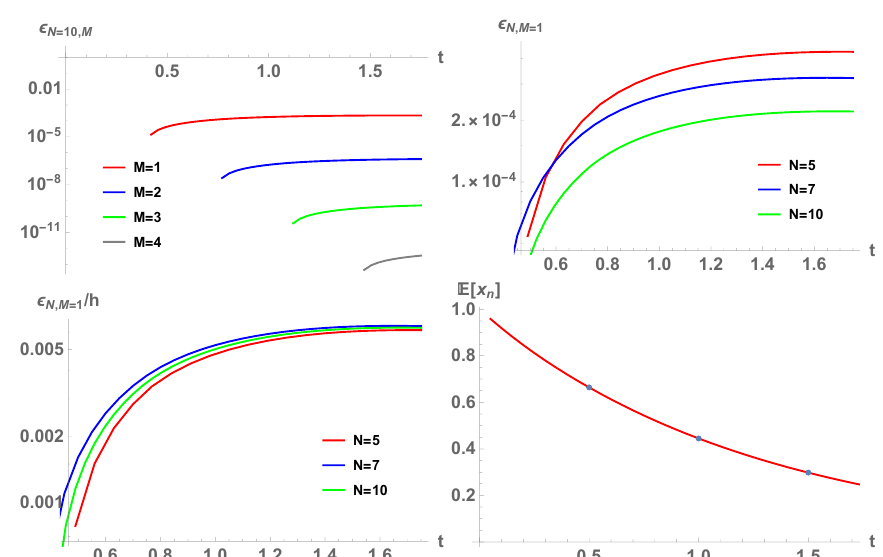
Figure 1. Upper left panel: Absolute errors (log-scale) in the approximation of the mean value with the NSFD scheme, with M = 1,2,3,4 and N = 10 ( h = τ / N ). Upper right panel: Absolute errors (log-scale) in the approximation of the mean value with the NSFD scheme, with N = 5,7,10 ( h = τ / N ) and M = 1. Lower left panel: Errors from the upper right panel divided by h . Lower right panel: Approximation of the expectation with the NSFD scheme, with M = 1 and N = 7, and comparison with Monte Carlo simulation (circles) using 10,000 realizations. This figure corresponds to Example 1.